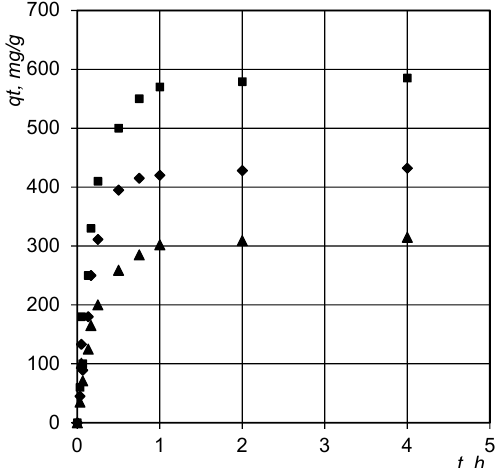
9 of 17 Figure 4. SEM micrographs of activated charcoal. 3.2. Influence of Contact Time on Diazepam Sorption